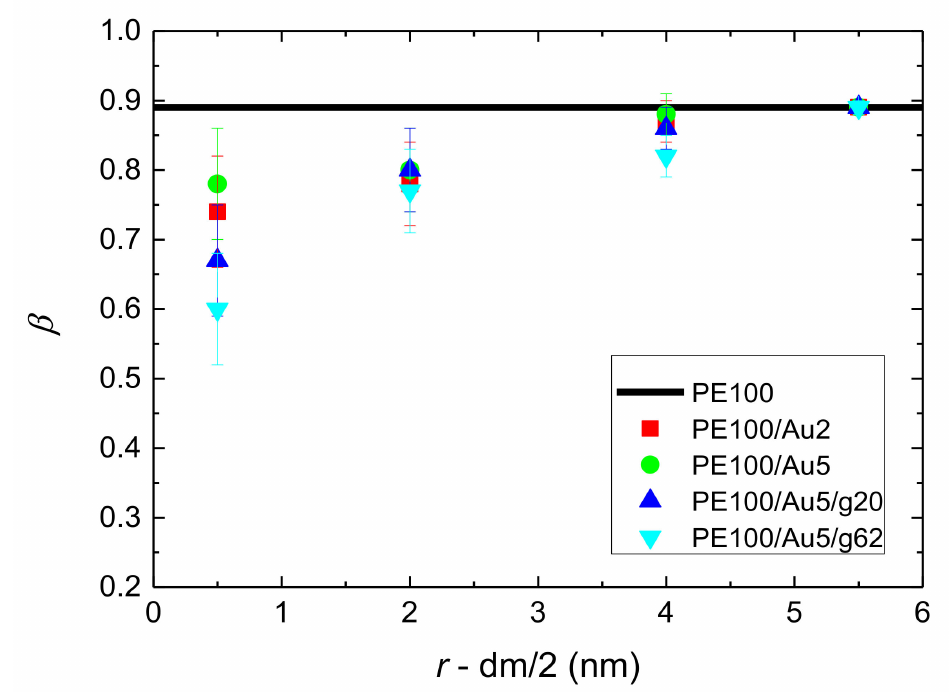
Figure 9. The stretch exponent β , as extracted from the fit with KWW functions, of the end-to-end vector ACF, C end-end ( t ), as a function of distance from the center of the Au NP, r , minus the half diameter of the NP for all systems with PE matrices consisting of 100 mers per chain. Black lines represent β values of bulk PE